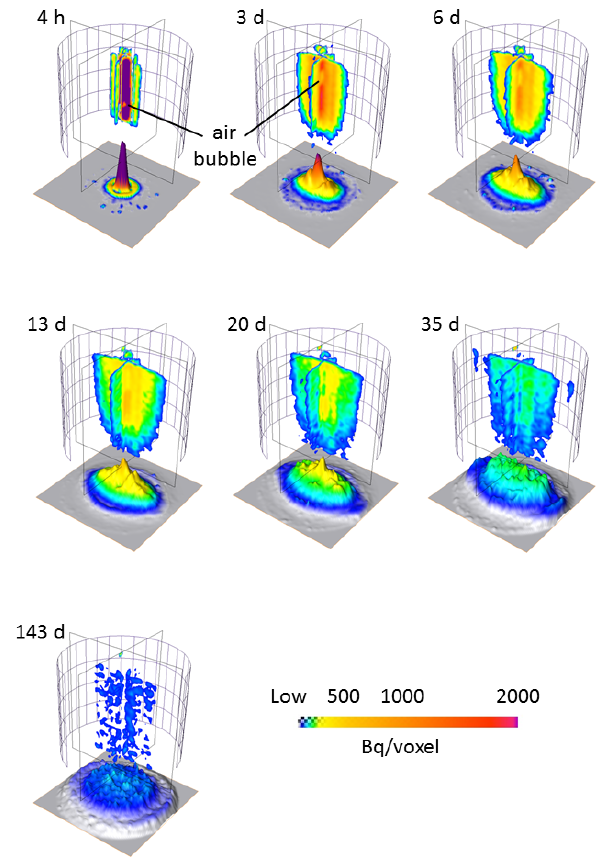
Figure 7. Vertical slices and axial projection of selected frames of Fig. 5, with uniform colour scale. At t = 35days, the tracer arrived at the cylinder